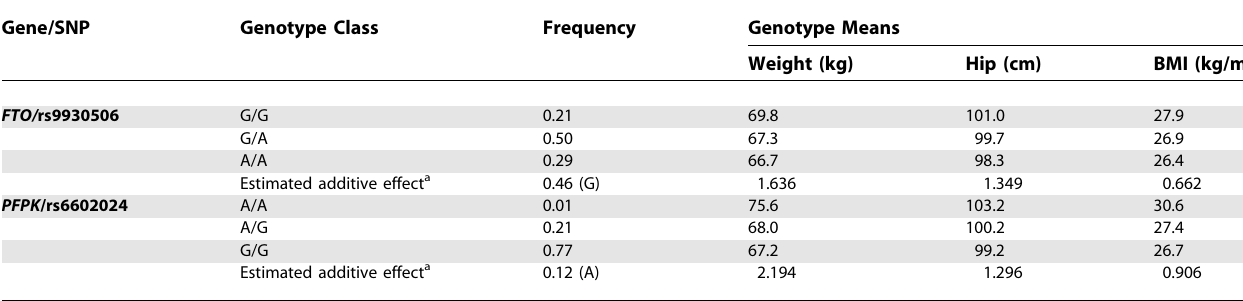
Table 2. Effects Associated with the rs9930506 and rs6602024 SNPs Gene/SNP